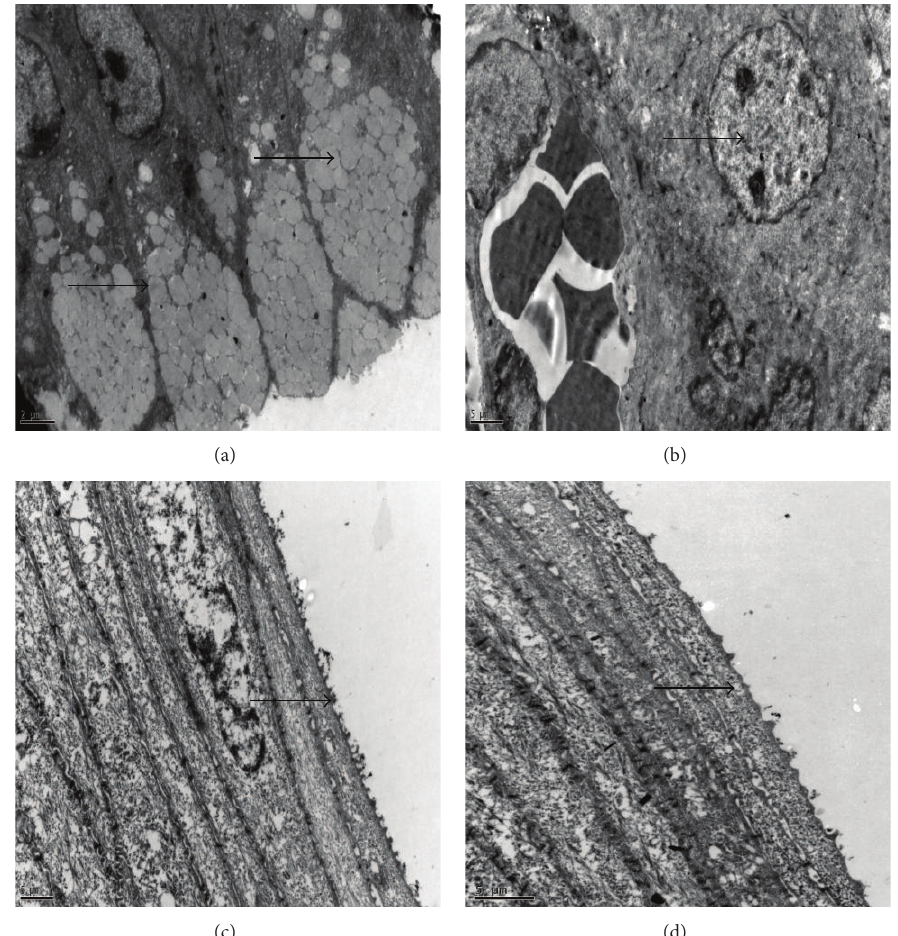
Figure 4: Transmission electron microscopy findings. Increased number of goblet cells and numerous secretory granules were observed in cytoplasm of goblet cells (arrows) in MSCs-treated group after one week of therapy (a). Degenerated goblet cells and decreased secretory granules were observed in cytoplasm of goblet cells (arrows) in PBS group after one week of therapy (b). Microvillus was preserved at apical portions of the corneal epithelium (arrows) of MSCs-treated rats and there was prominent sign of cellular injury at cornea of these rats after one week of therapy (c). Degeneration and loss of microvillus at apical portions of the corneal epithelium and signs of separation of cells from each other were observed in PBS-treated rats (d) (Joel JEM-1400 model, magnification (a), (b): × 8000 and (c), (d): ×